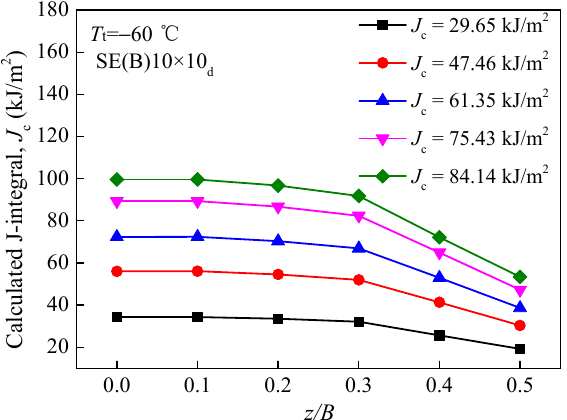
Figure 5. Calculated J integrals around crack fronts.